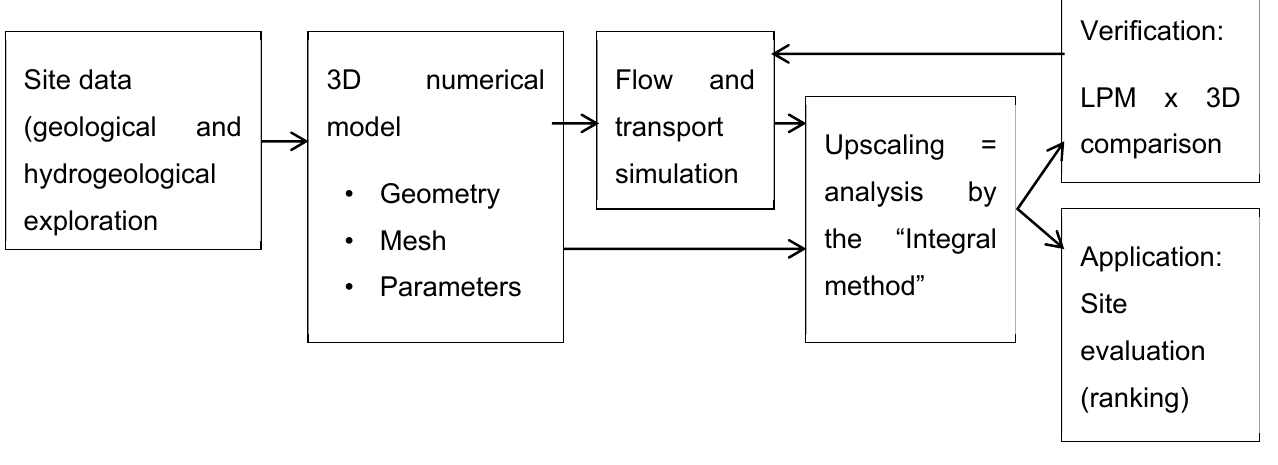
Figure 4. Workflow of the developed method, with two final steps: the lower is the intended use of the method and is presented in Section 4 as an example; the upper is only considered as a part of this paper for justification and was done once.